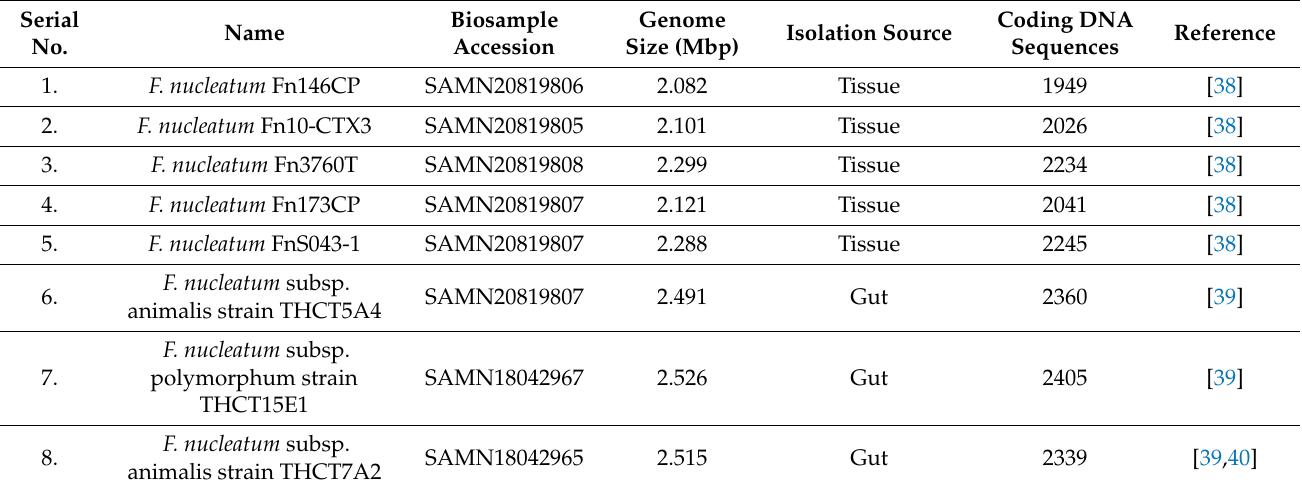
Table 1. F. nucleatum genomes used in this study, either derived from colon cancer site, tissue, or gut of the ailing